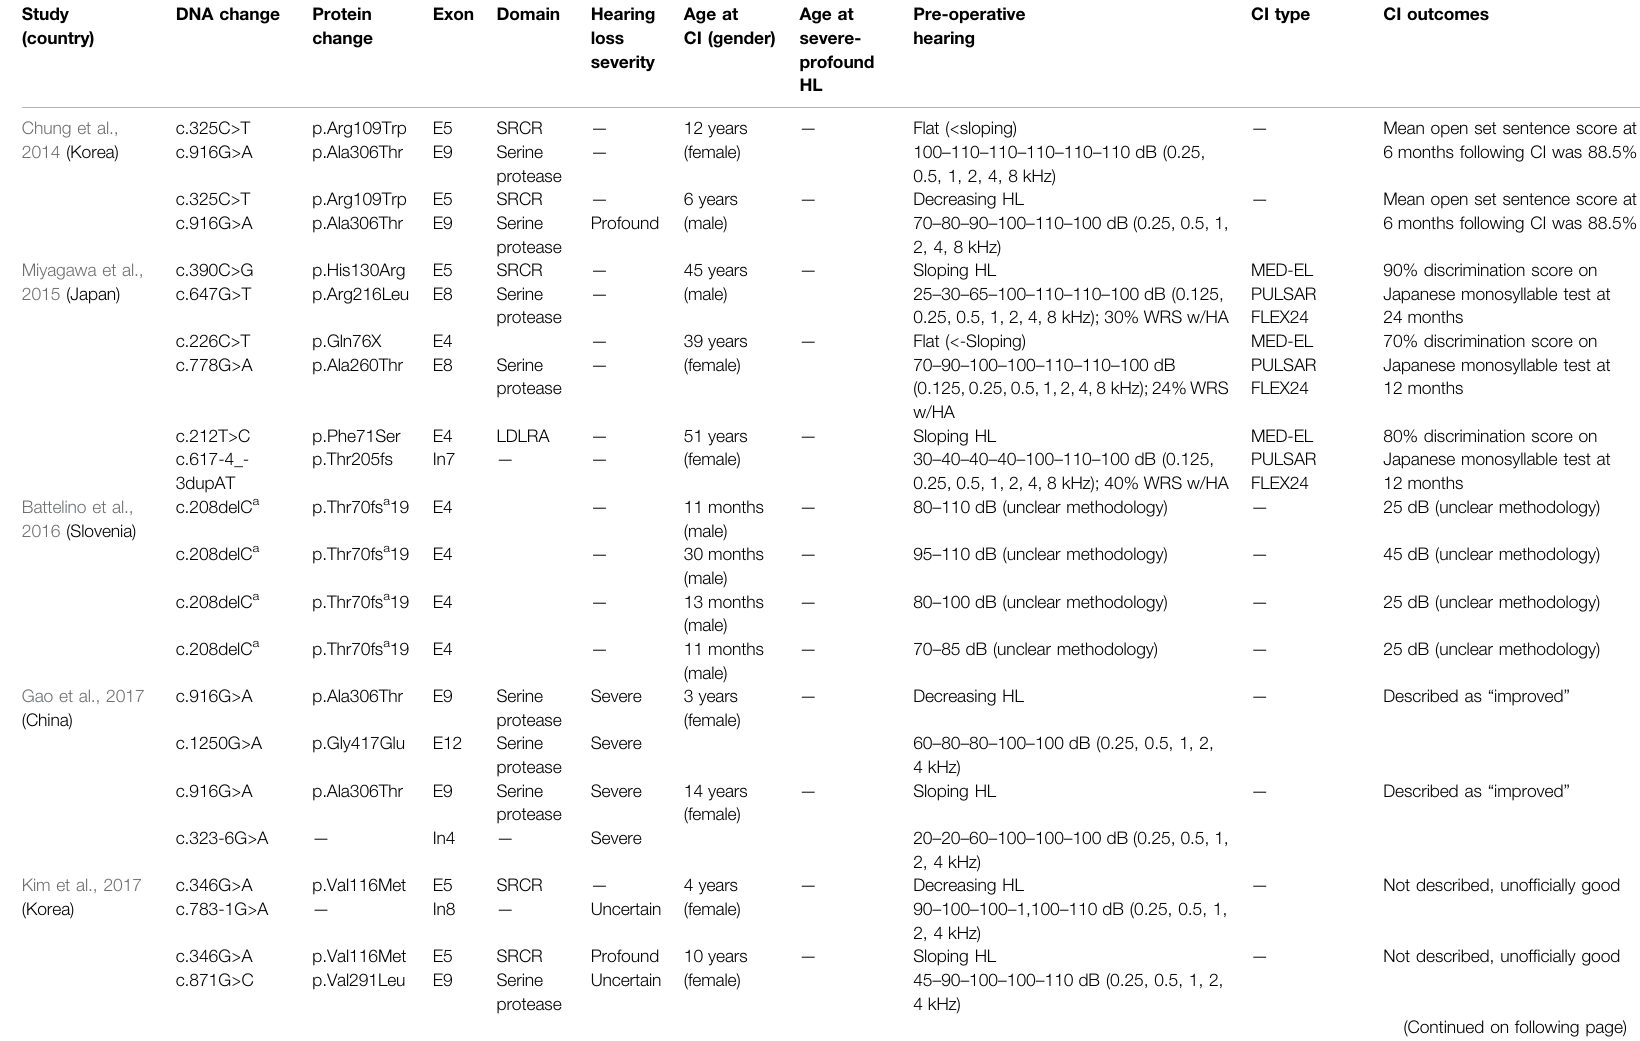
TABLE 2 | ( Continued ) Overview of clinical characteristics and genotypes of patients with TMPRSS3 variants who have received cochlear